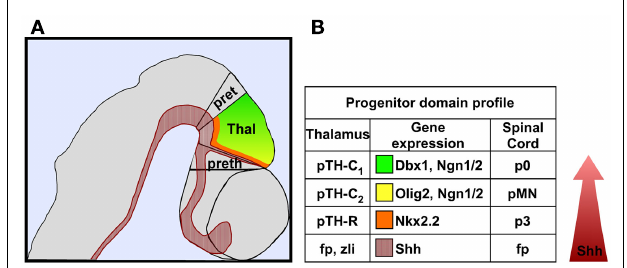
FIGURE 2 |A morphogenetic gradient of Shh signaling establishes distinct thalamic progenitor domains. (A) Schematic representation of a lateral view of the caudal diencephalon color-coded as follows: Shh expressing cells (red); pTH-C 2 domain (yellow); pTH-C 1 domain (green); pTH-R domain (orange). (B) Comparison of a representative set of genes expressed in thalamic and ventral spinal cord progenitor